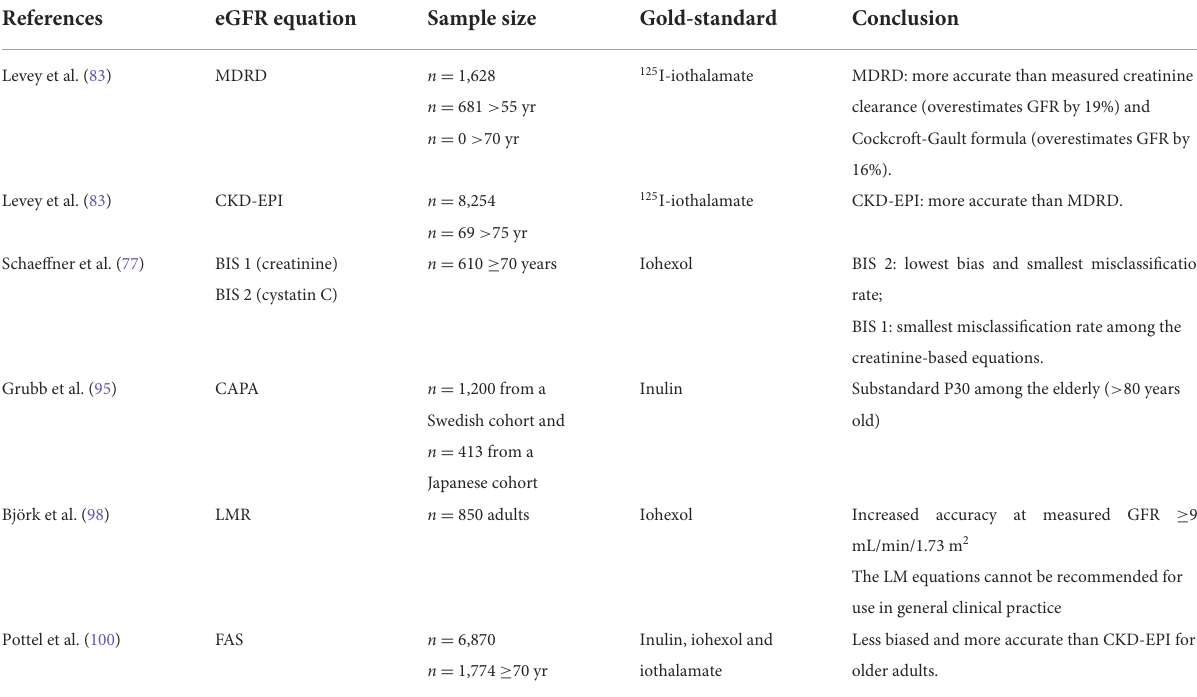
TABLE 3 Summary of studies addressing equations to estimate glomerular filtration rate and participation of older